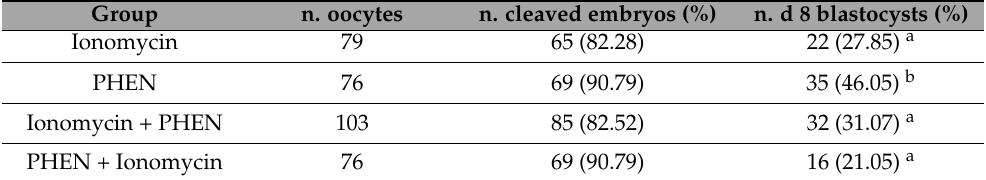
Table 5. In vitro preimplantation development of parthenogenetic porcine embryos using Zn chelator PHEN or Ionomycin.